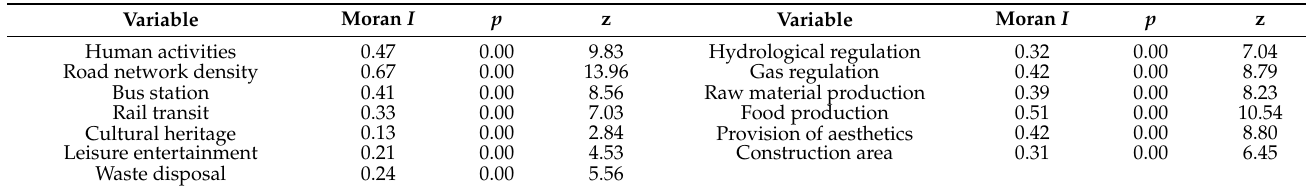
Table 2. Moran’s I test of human activities and LFs.